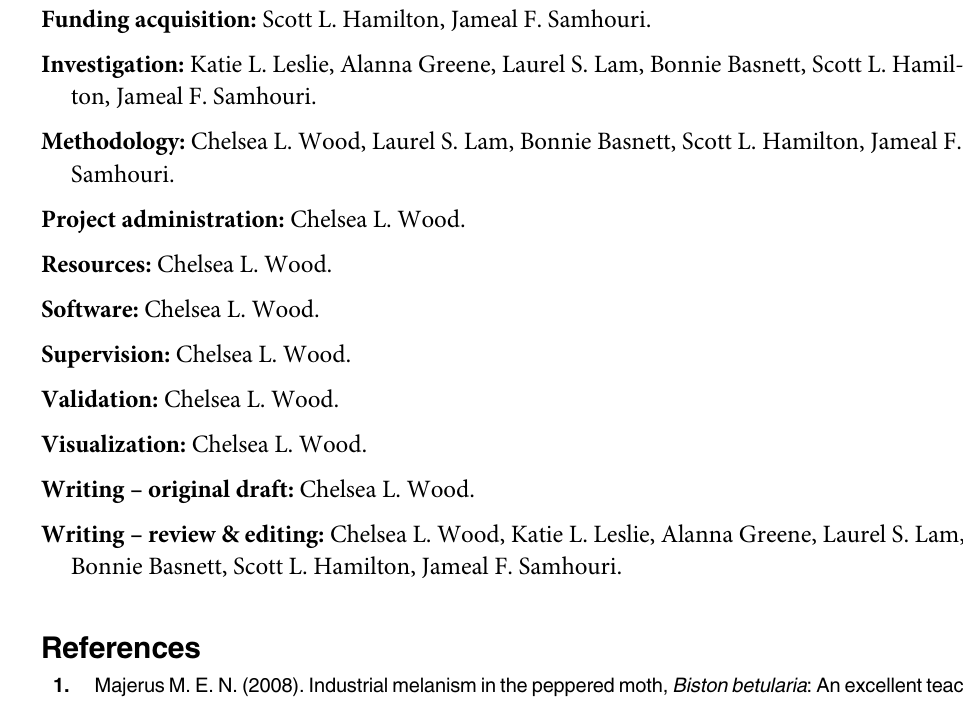
S1 Table. Parasite taxa detected in